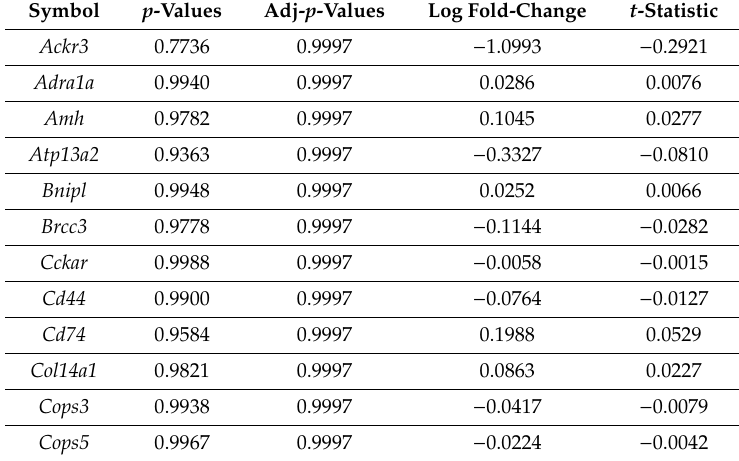
Figure 1. Enrichment of the migration inhibitory factor (MIF) network in Duchenne muscular dystrophy (DMD). Study layout ( A ). Overlapping between the di ff erentially expressed genes (DEGs) in DMD samples, as determined in the meta-analysis of the GSE6011 and GSE38417 datasets, and the MIF network ( B ). MIF network showing the DEGs identified in the meta-analysis. Nodes are color-coded based on the observed E ff ect Size ( C ). Z score of the expression levels of MIF, DDT, CD74 and CD44 in the GSE6011, and GSE38417 datasets ( D ). Table 1. Di ff erential expression analysis of MIF-related genes in in-vitro di ff erentiated myotubes from healthy donors and DMD patients, as determined in the GSE79263 dataset. Values are approximated to four digits.